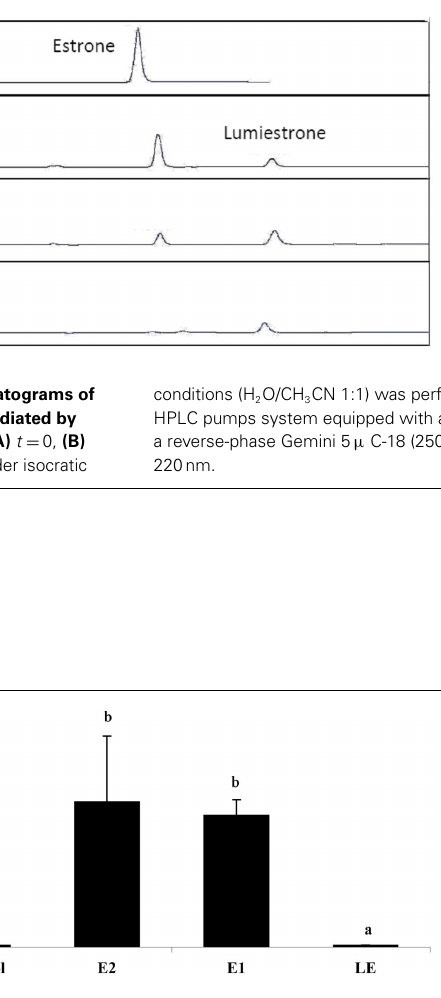
FIGUREA5 |The effect of i.p. injections (0.5 μ g/g) of estradiol (E2), estrone (E1), lumiestrone (LE), and control (charcoal-stripped peanut oil; 5 μ L/g) on expression of liver estrogen receptor (ER) α in sexually in sexually inactive male goldfish using multiplex real-time PCR (8) after 24h. Data ( n = 6) are expressed as the mean ( n = 6; ± SEM) fold change relative to the ER β / β -actin ratios of the controls. Data were tested for normality and homoscedasity, and were transformed when appropriate prior to analysis by one-way ANOVA (treatment; p < 0.001) followed by Tukey’s post hoc test (S-Plus, v8.0). a,b Means labeled with different superscripts are significantly different ( p < 0.05). Note that ER β 1 and ER β 2 mRNAs were also measured in this PCR (not shown) but were not